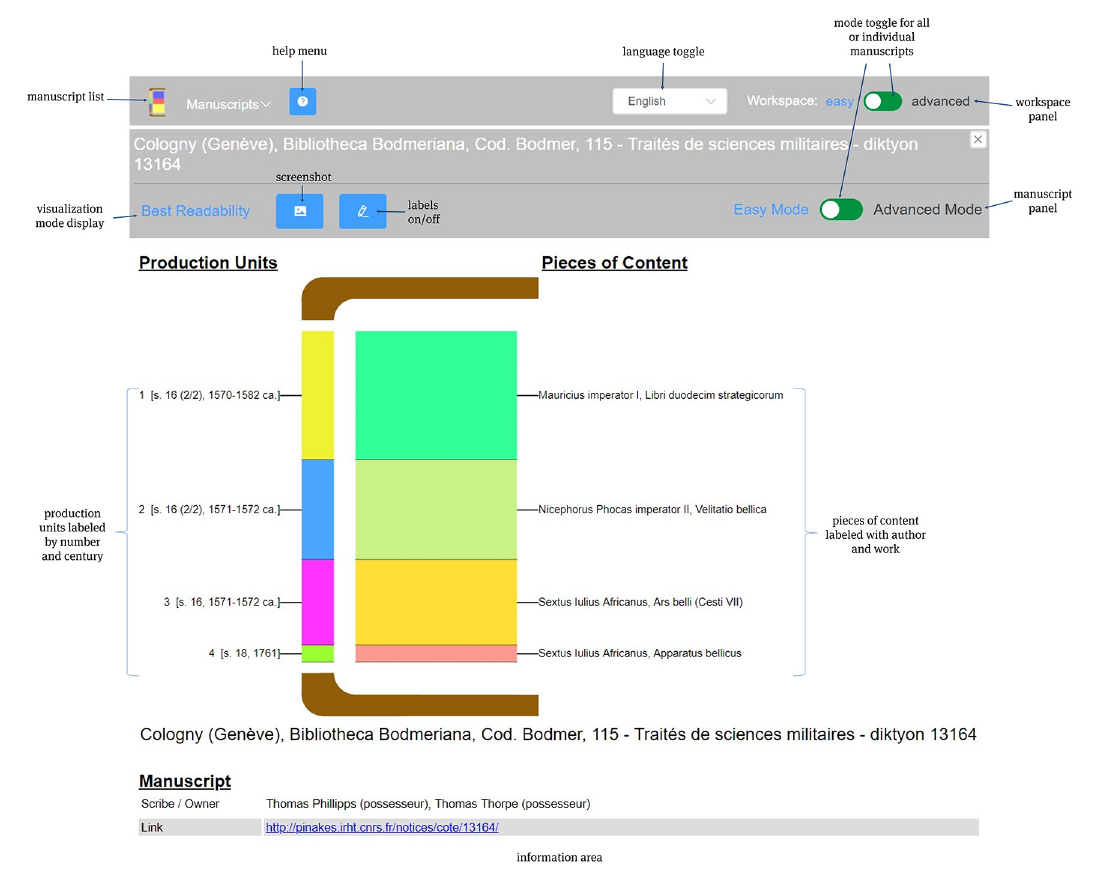
Figure 3. StruViMan Visualization of Codex Bodmer 115